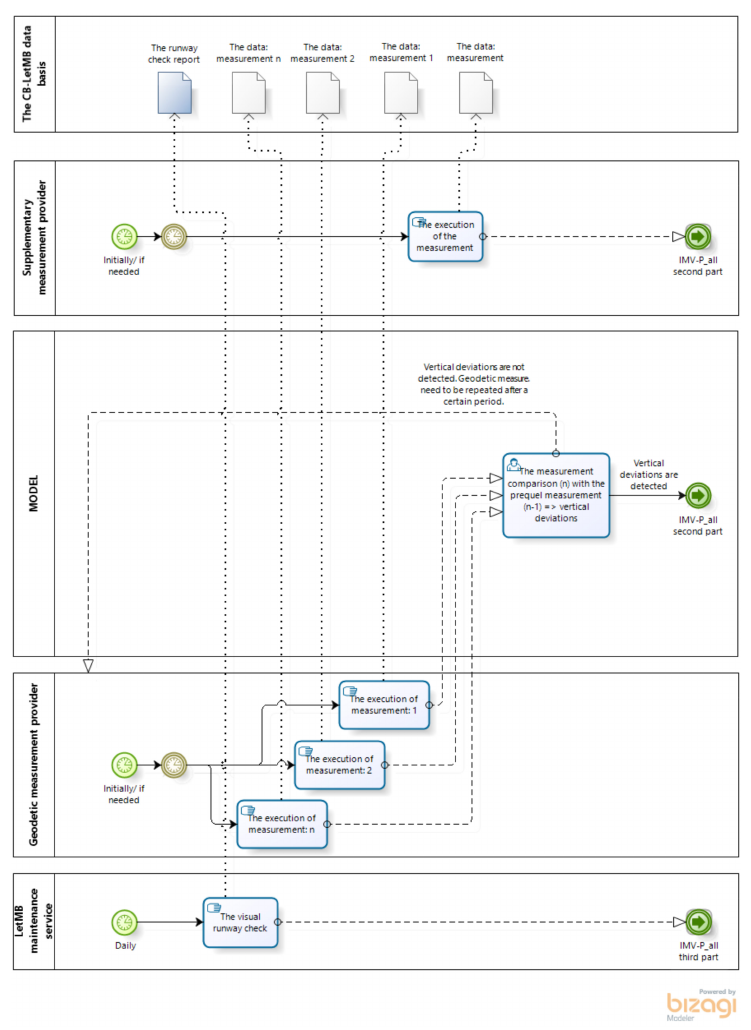
Figure 2. The APMS-MB, Edvard Rusjan Airport in Maribor (MB) process model.